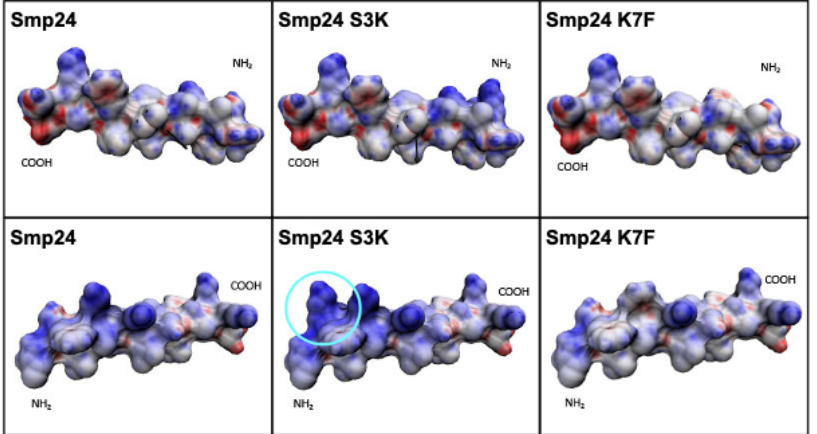
Figure 6. Space filling models of Smp24 and Smp24 derived peptides. Polar facets are highlighted in blue and non-polar facets are highlighted in red, using the HM calculator [28].